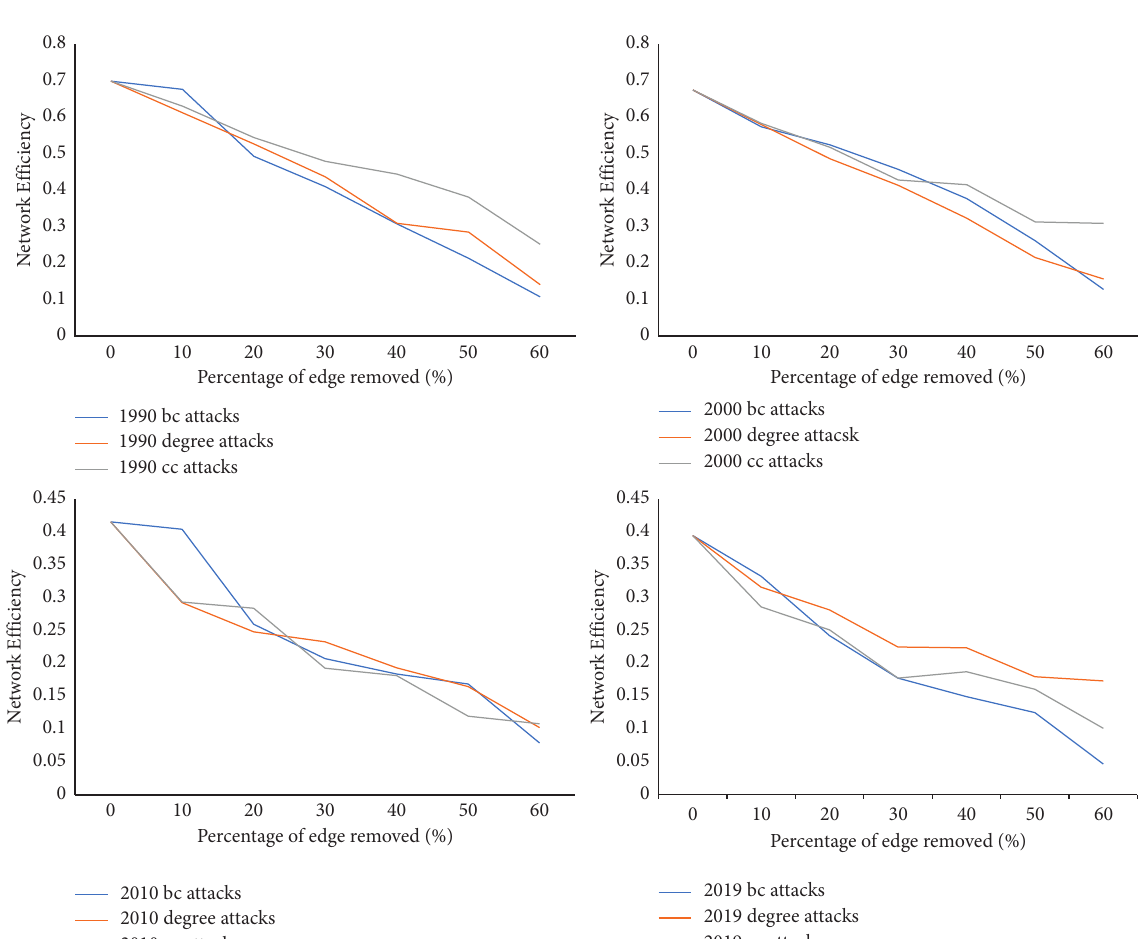
Figure 3: Evolution of the community structures of the USACN from 1990 to 2019.